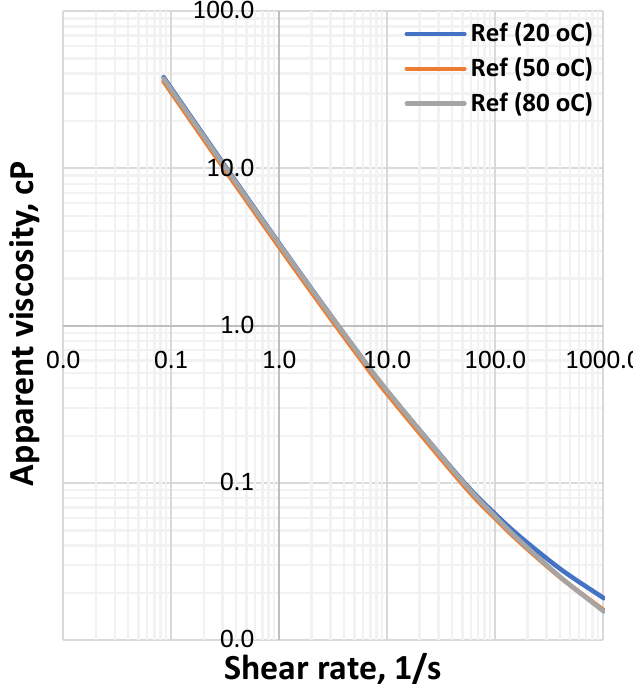
Figure 6. Reference MoS 2 -free drilling fluid.